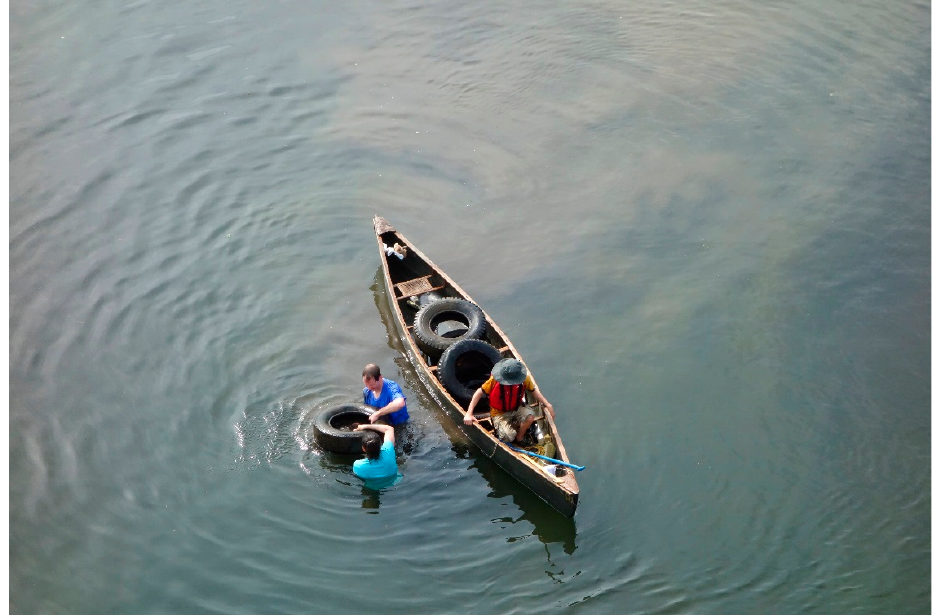
Figure 4. Lewisburg residents pull decades-old tires out of the muddy riverbed beneath the Market St. bridge in 2014. St. bridge in